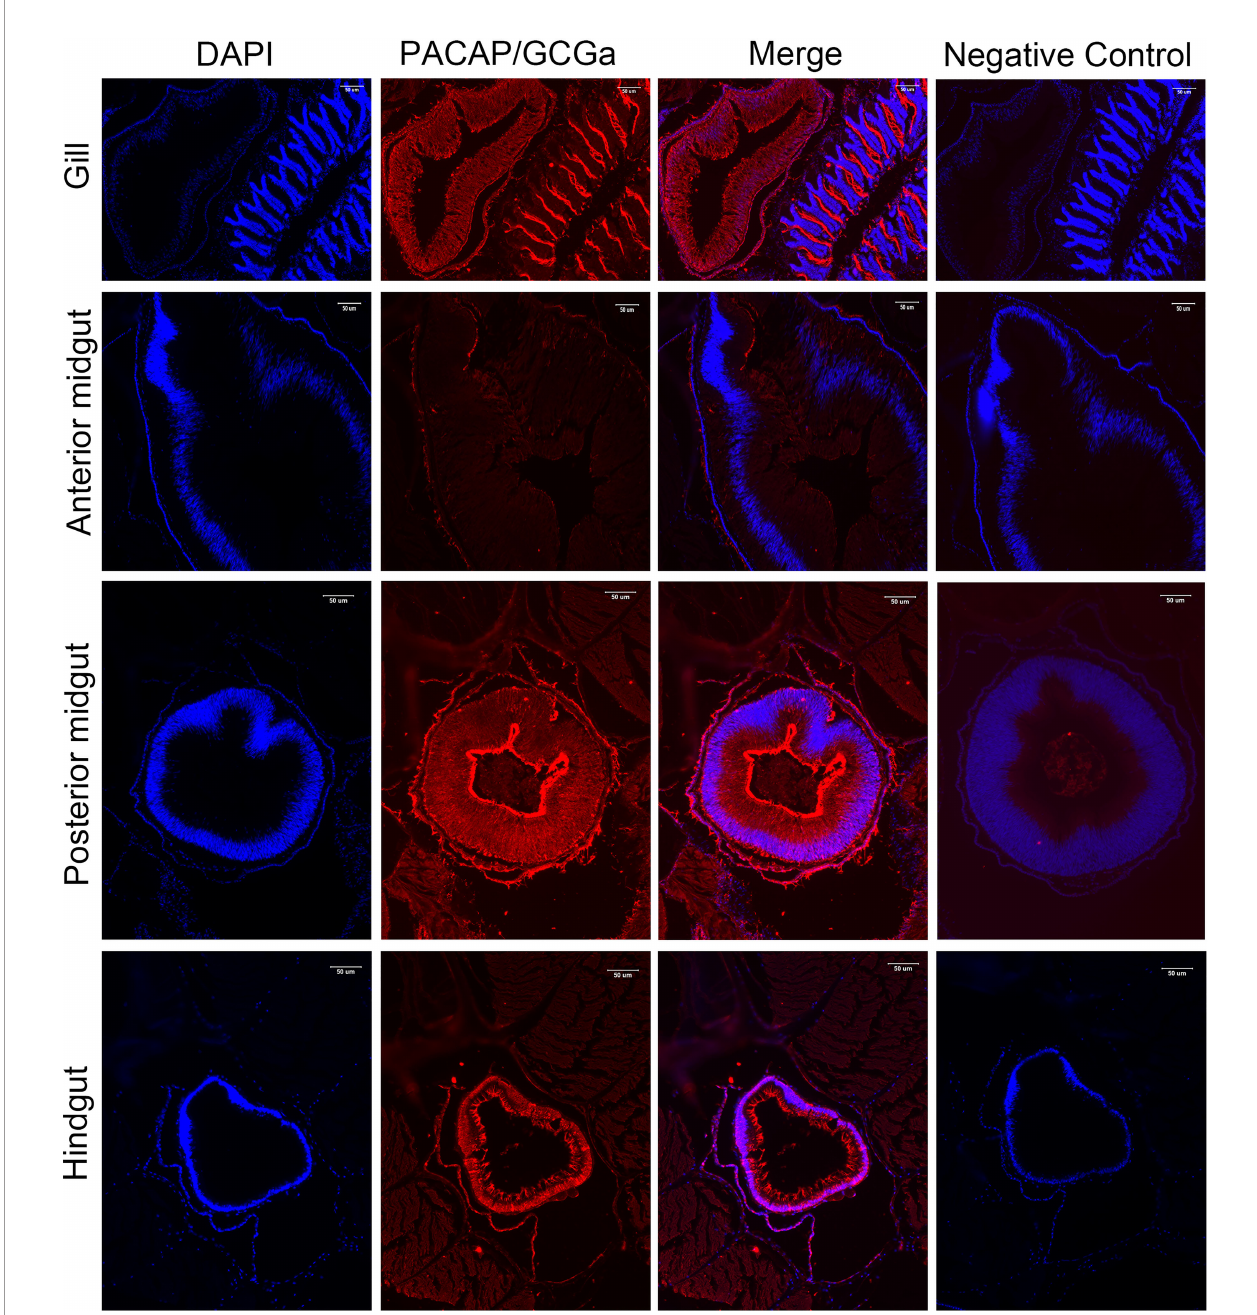
FIGURE 3 | Detection of PACAP/GCGa in several adult B . belcheri tissues by immuno fl uorescence. Immuno fl uorescence digital images of DAPI staining (blue), PACAP/GCGa (red) positive signals, and merged and negative control (merged). Negative controls represent the result of incubations in which primary antibody with overnight incubation with antigen in 1:10 molar ratio was used to replace primary antibody alone. PACAP/GCGa peptides were detected in the gill, midgut, and hindgut. N, notochord; Hp, Hatschek ’ s pit. The scale bar is 50 m m and is indicated in the fi